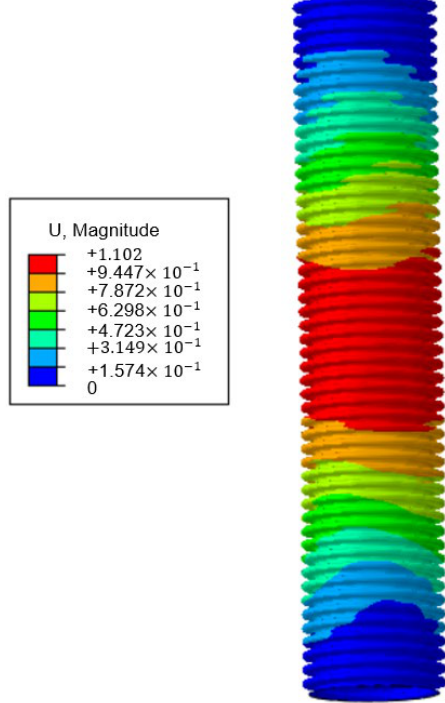
Figure 18. Linear buckling mode of the FE model.